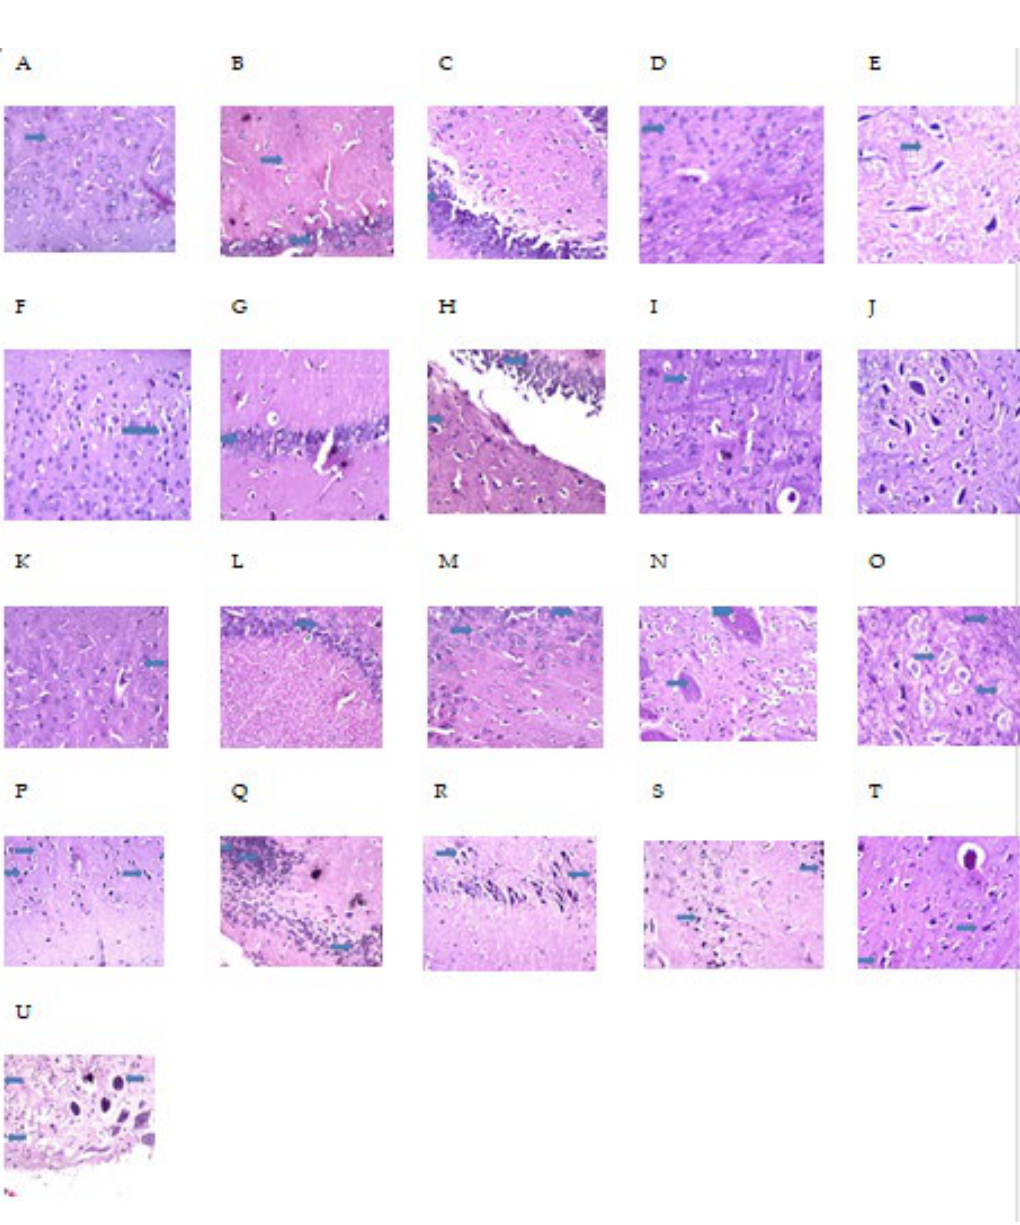
Figure 11. Photomicrographs ( A – E ): Transverse brain tissue sections from control NF group illus- trating no histopathological alteration in: cerebral cortex ( A ); hippocampus ( B ); striatum ( C ); and substantia nigra ( D , E ) (arrows). Photomicrographs ( F – J ): transverse brain tissue sections from con- trol PM animals’ cerebral cortex showed focal nuclear pyknosis and degeneration in the neuronal cells ( F ). There was no histopathological alteration in the hippocampus as well as in the striatum ( G – I ) (arrows). Atrophy was detected in some neurons of the substantia nigra ( J ). Photomicrograph alteration in cerebral cortex ( K ) and hippocampus ( L , M ) (arrows). Focal plagues formation as